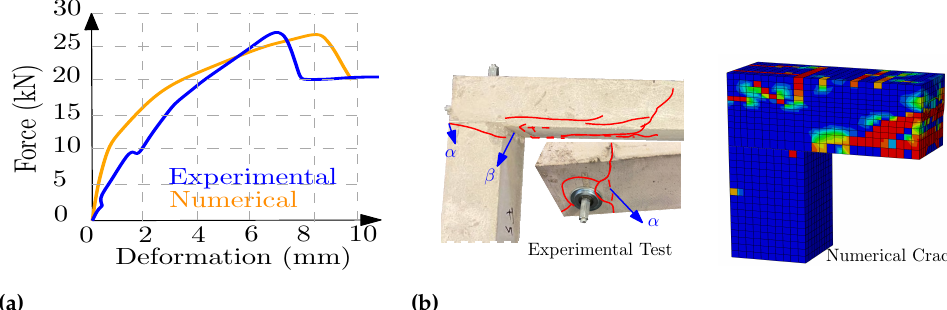
Figure 14. F5, ( a ) Force–deformation, ( b ) experimental cracking and numerical cracking